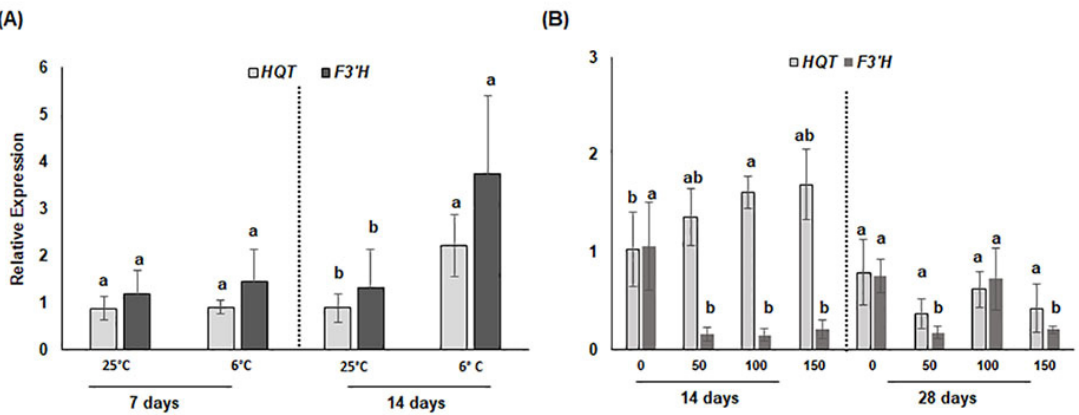
Figure 2. ( A , B ) Relative expression changes of CcHQT and CcF3 (cid:48) H biosynthetic genes in cardoon callus cultures in response to ( A ) chilling stress for 7 and 14 days at 6 ◦ C or ( B ) saline stress at 0, 50, 100 or 150 mM NaCl for 14 and 28 days. Total RNA was extracted from unstressed (CTR) and treated calli (chilling or salt stress) and unstressed calli at each time point were used as controls. Each value represents the mean of three biological replicates ± SD. Statistical significance for each gene between treatments within each time point was determined by using one-way ANOVA with Tukey’s post hoc test. Different letters indicate significant difference ( p -value < 0.05 ).